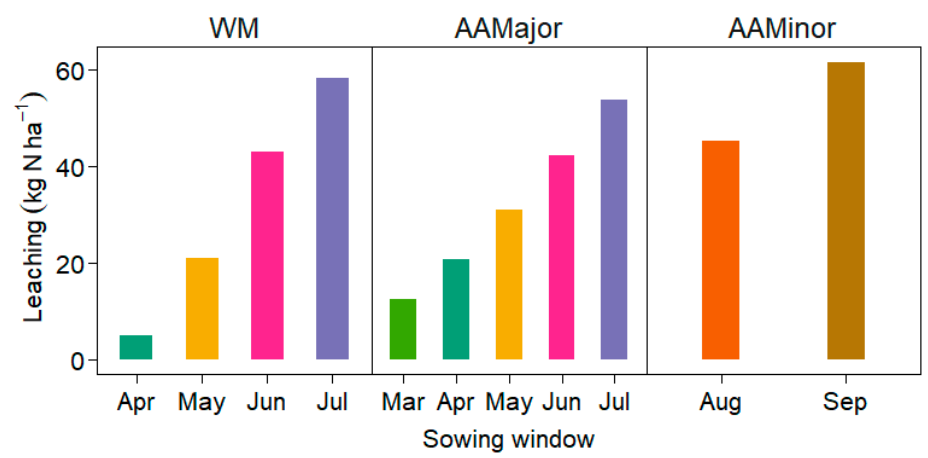
Figure 14. Simulated leaching (kg N ha − 1 ) loss for a 1.20 m rooting depth, different sowing windows (x axis) and fertilization treatment 75 kg N ha − 1